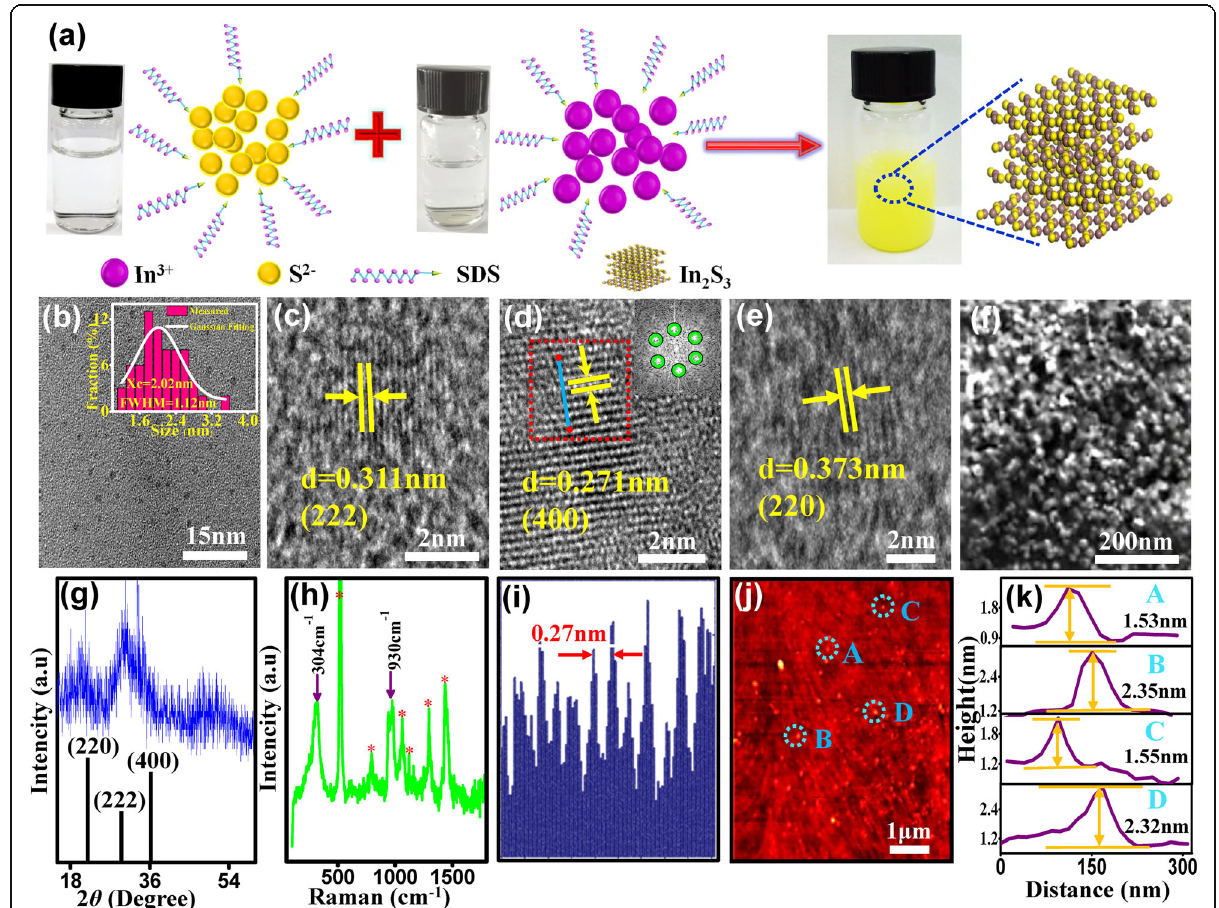
Fig. 1 a The schematic illustration of the preparation of In 2 S 3 QDs. b TEM image and size distribution (inset) the white line is the Gaussian fitting curve. c – e HRTEM images, inset of FFT image of a selected red area. f The SEM image. g XRD spectrum. h Raman spectrum. i The line profile of the diffraction fringes in ( d ). j The AFM image. k The height analysis of randomly selected In 2 S 3 QDs labeled as A, B, C, and D in